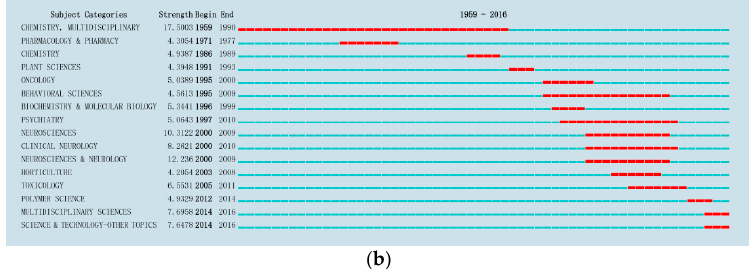
Figure 5. Major disciplines of P. ginseng and burst detection result. ( a ) Category co-occurrence network; ( b ) 16 subject categories have occurrence burst during 1959–2016.